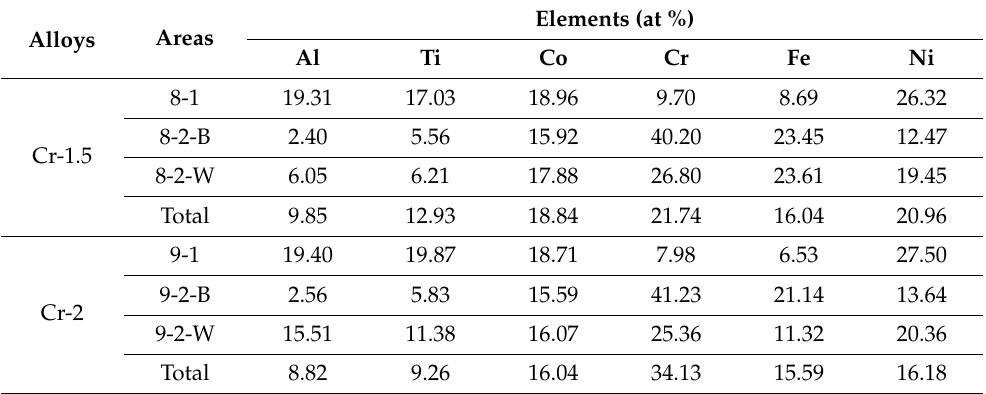
Figure 5. Microstructure and XRD results for Al0.5CoCr x FeNiTi0.5 HEAs: ( a , b ) Cr-1.5 alloy, ( c ) Cr-2 alloy; and ( d ) XRD results. Table 6. EDS results for Al0.5CoCr x FeNiTi0.5 HEAs.